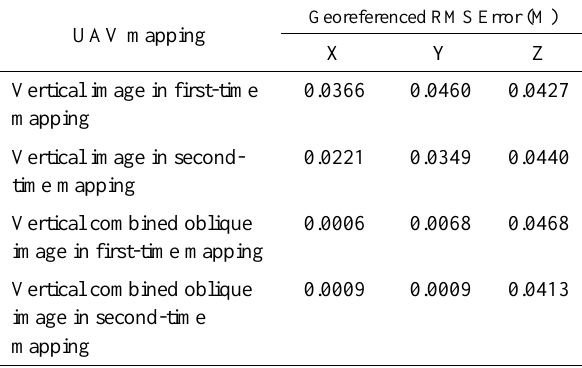
Table 6. Showing the root mean square error X, Y, Z of